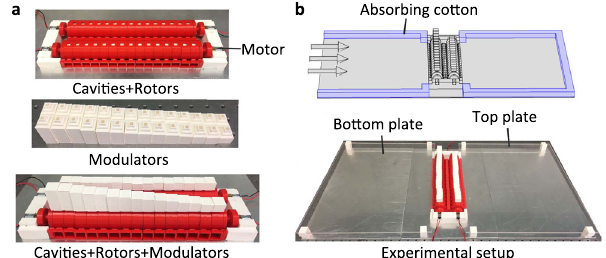
Fig. 4 Experiment setup. a Photograph of different components of the JAM, including rotors, cavities, and modulators. The array of JAM device consists of 15 unit cells. b Schematic diagram and the photograph of the experiment setup.